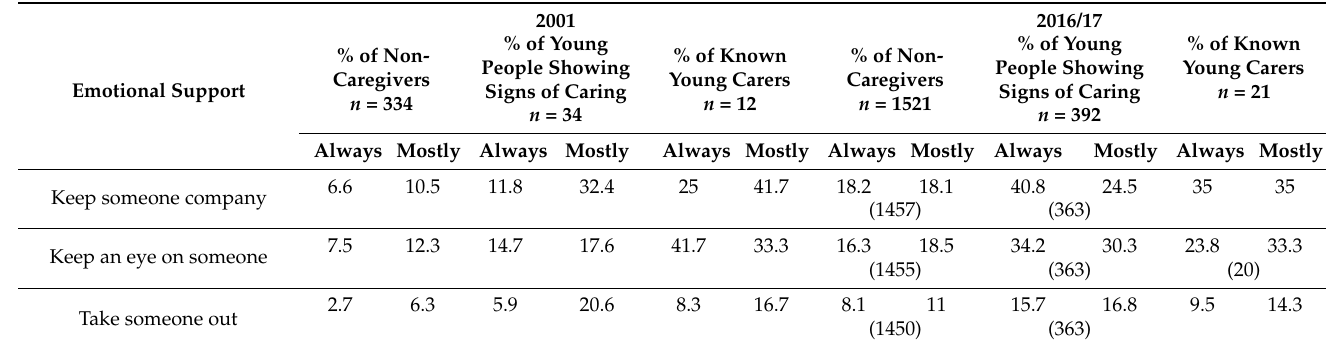
Table 8. Frequency of emotional support undertaken by non-caregivers, young people showing signs of caring and known young carers in 2001 and